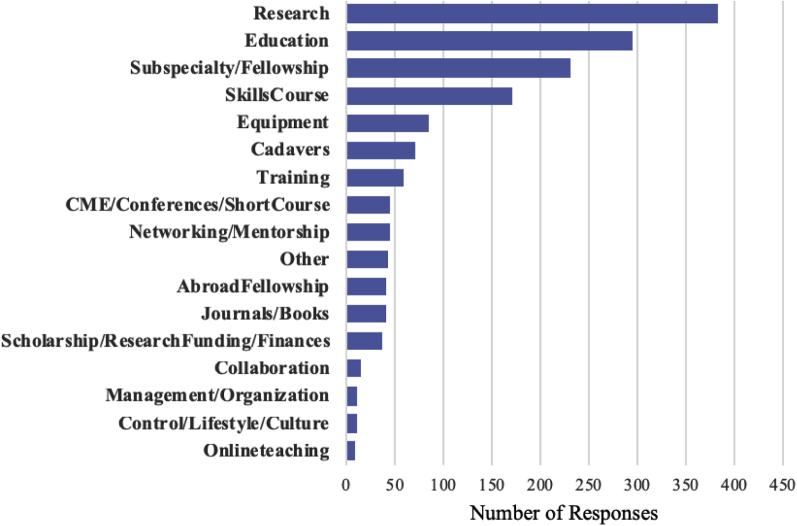
Detailed categorization of respondents' requests for improvement in their current neurosurgical system. Of the 1673 individual requests for system improvement, the most frequent request was for research (384 individuals), followed by additional education (296 individuals), and additional subspecialty or fellowship training requests (232 respondents). The subspecialties of interest are shown below. Twenty-five percent of fellowship requests came from high-income countries, 26.3% from upper-middle-income countries, 44.0% from low-middle-income countries, and 4.74% from low-income countries. CME, continuing medical education.